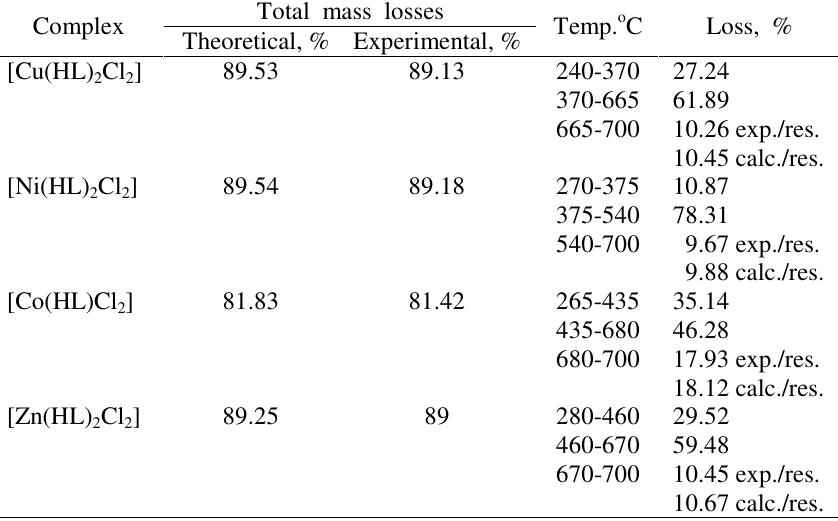
Table 3. Thermal analysis for the complex